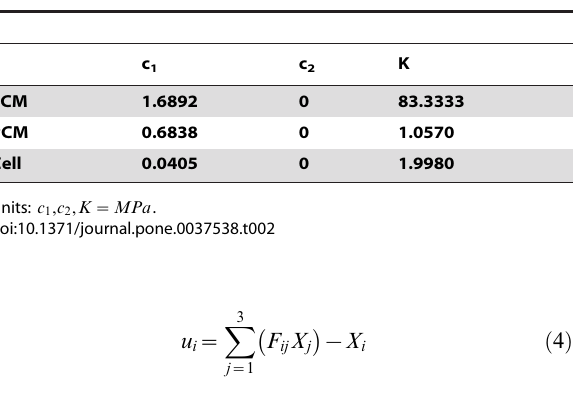
Table 2. Material parameters for micro-scale model [41].